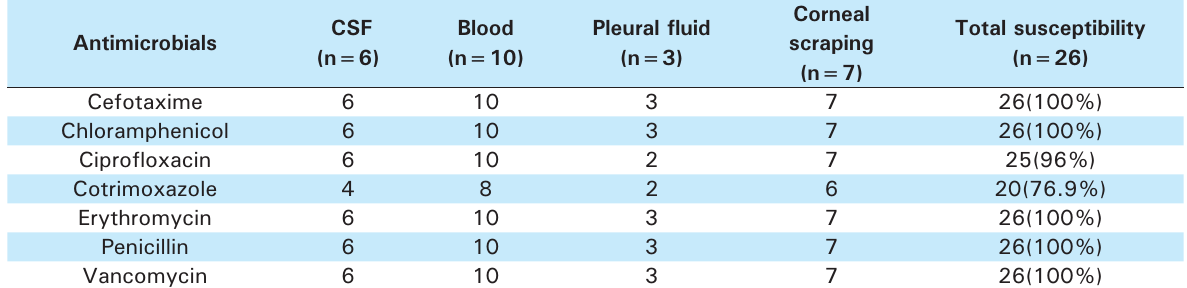
Table 2. Antimicrobial susceptibility pattern of S. pneumoniae in BPKIHS hospital on the basis of disc susceptibility testing